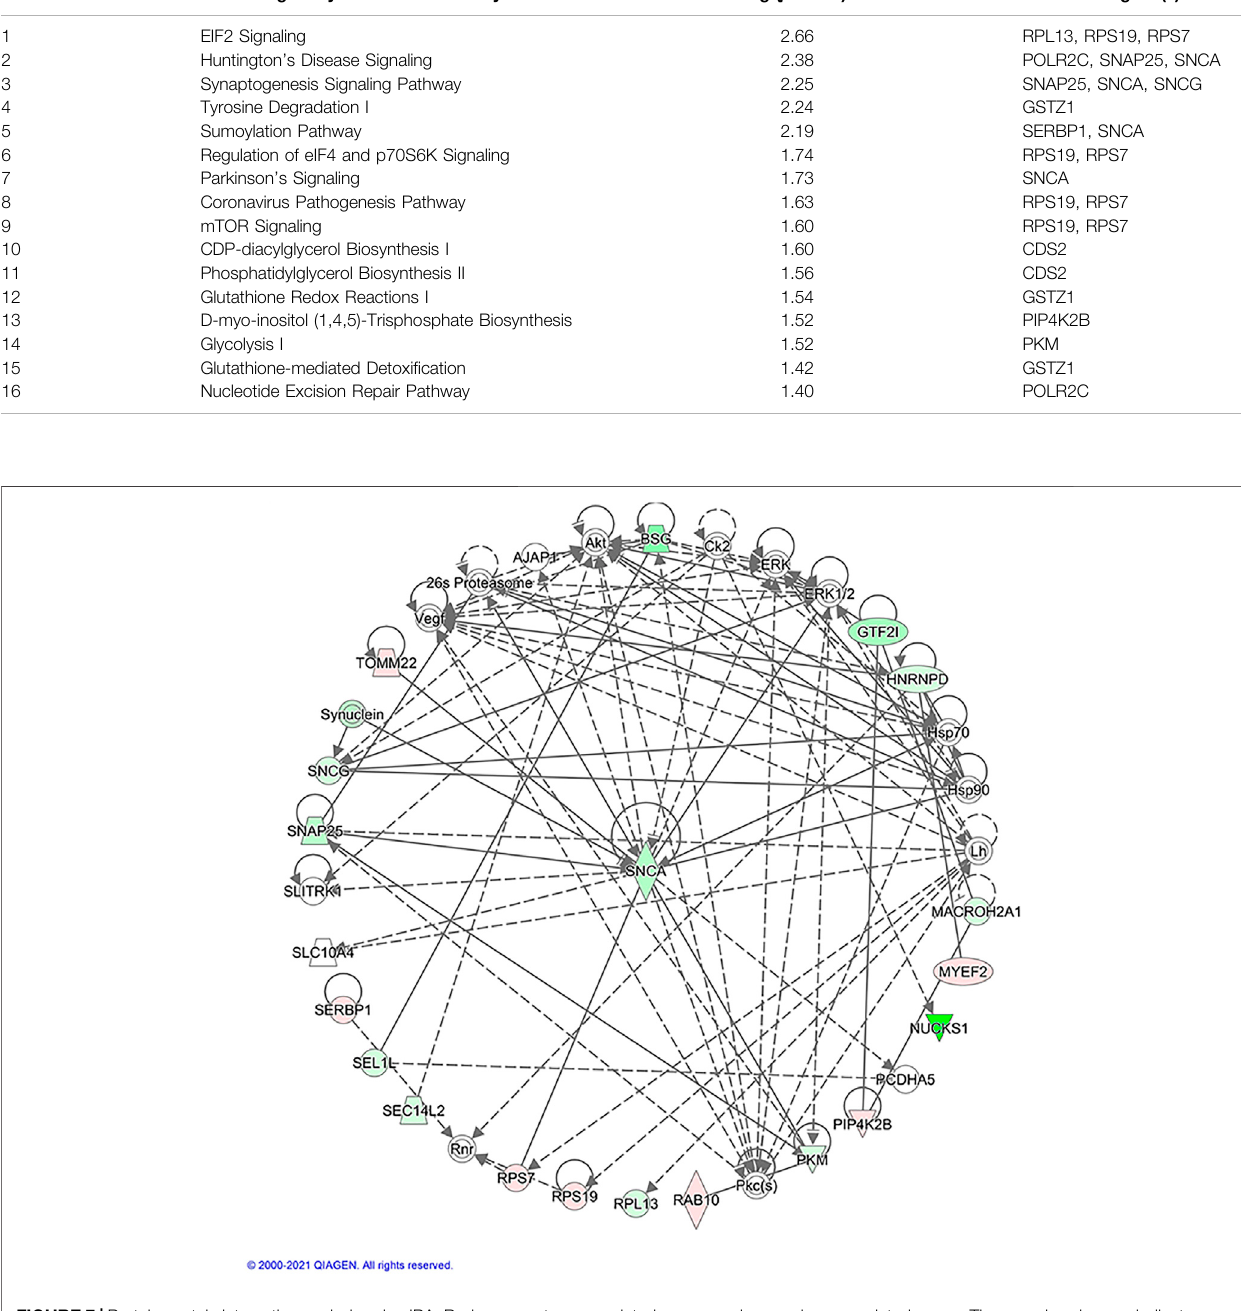
FIGURE 7 | Protein-protein interaction analysis using IPA. Red represents up-regulated genes, and green down-regulated genes. The un-colored genes indicate additional linked proteins of this network that were not detected by the proteomics analysis. The solid lines represent a robust correlation with partner proteins, and dashed lines represent statistically signi fi cant,butless frequent correlations.Theprotein-proteininteractionsareindicated byarrows. Thedifferentshape nodes indicate different protein functions: enzymes (diamond); nuclear receptors (rectangle); transcription regulators (oval); cytokines (square); transporter (trapezoid); and others